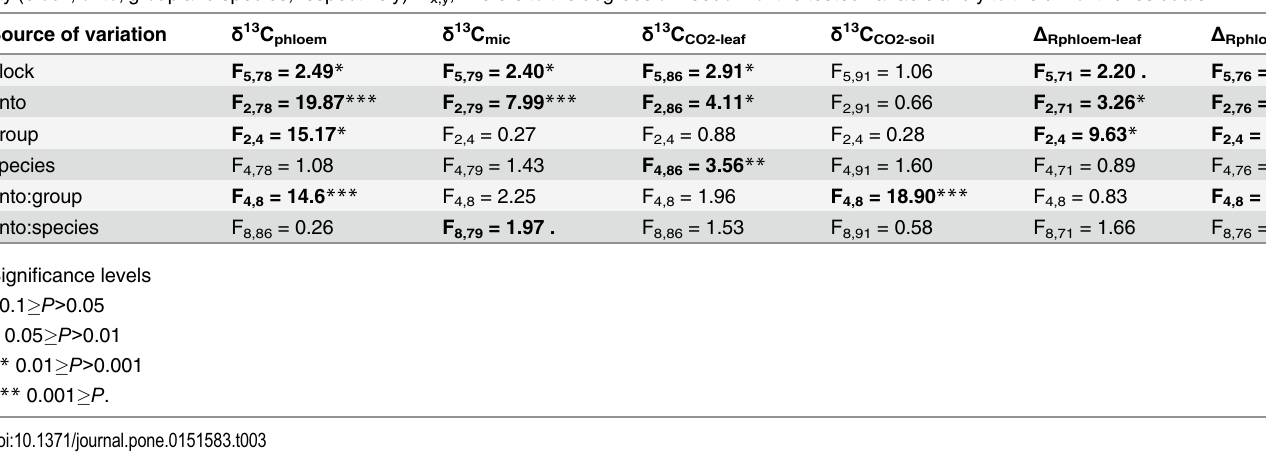
Table 3. ANOVA results for δ 13 C values, and respiratory C isotope fractionation between phloem sap organic matter and leaf- and soil-respired CO 2 ( Δ Rphloem-leaf and Δ Rphloem-soil , respectively). The variables are growth chamber, plant ontogenetic stage, functional group identity, and species iden- tity (block, onto, group and species, respectively). F x,y , x refers to the degrees of freedom of the tested variable and y to the d.f. of the